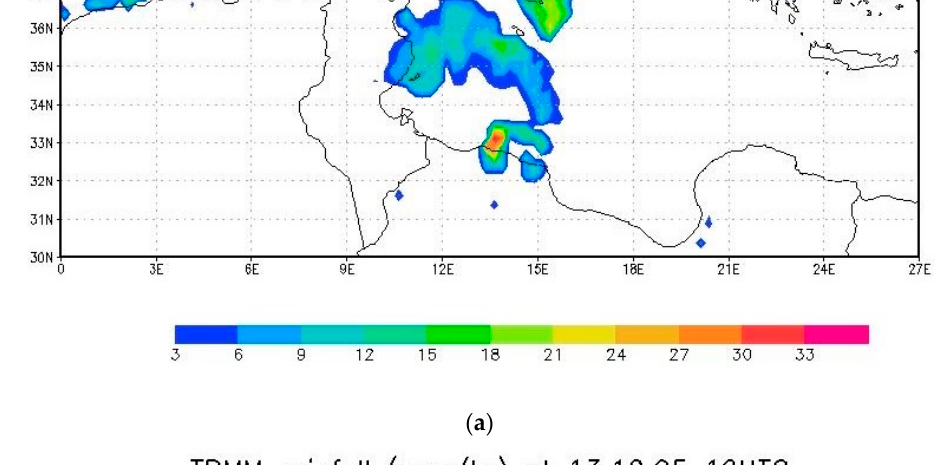
Figure 5. 10 m wind on 14 December 2005 03:00 UTC during the peak of the storm [16]. Wind speed contours in m s − 1 .